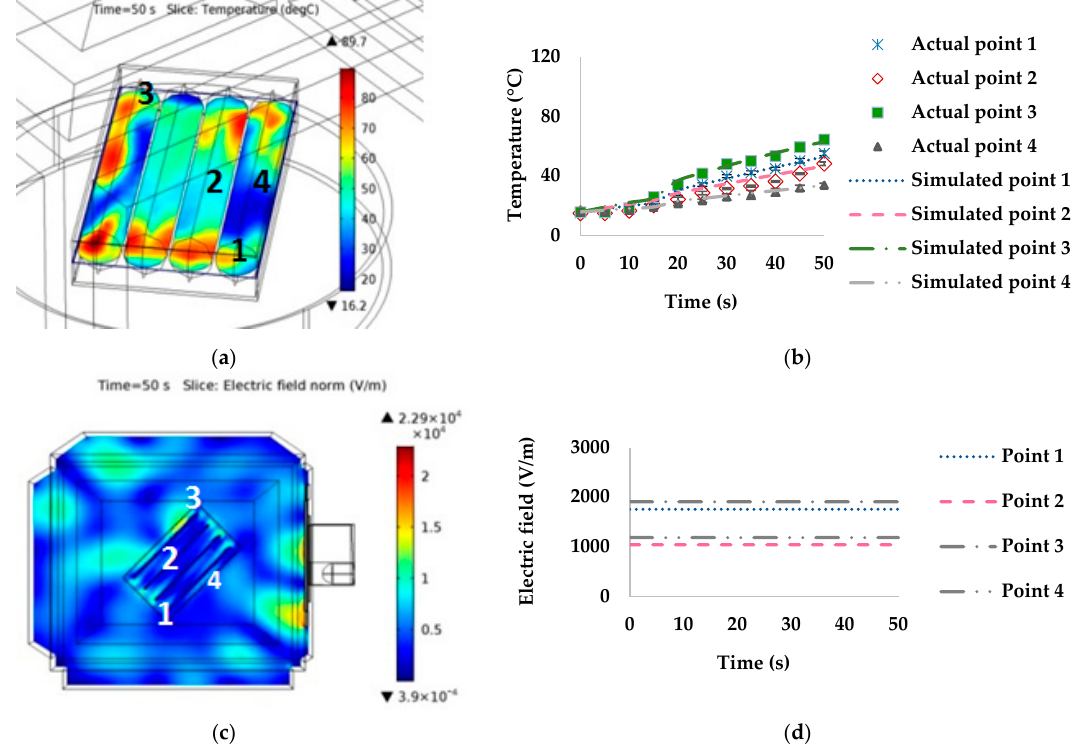
Figure 9. Effect of simulated stationary microwave on ( a ) thermal simulation, ( b ) temperature profile at points 1–4, ( c ) electric field, and ( d ) electric field profiles at points 1–4 of ready-to-eat sausage at 135° orientation to waveguide.